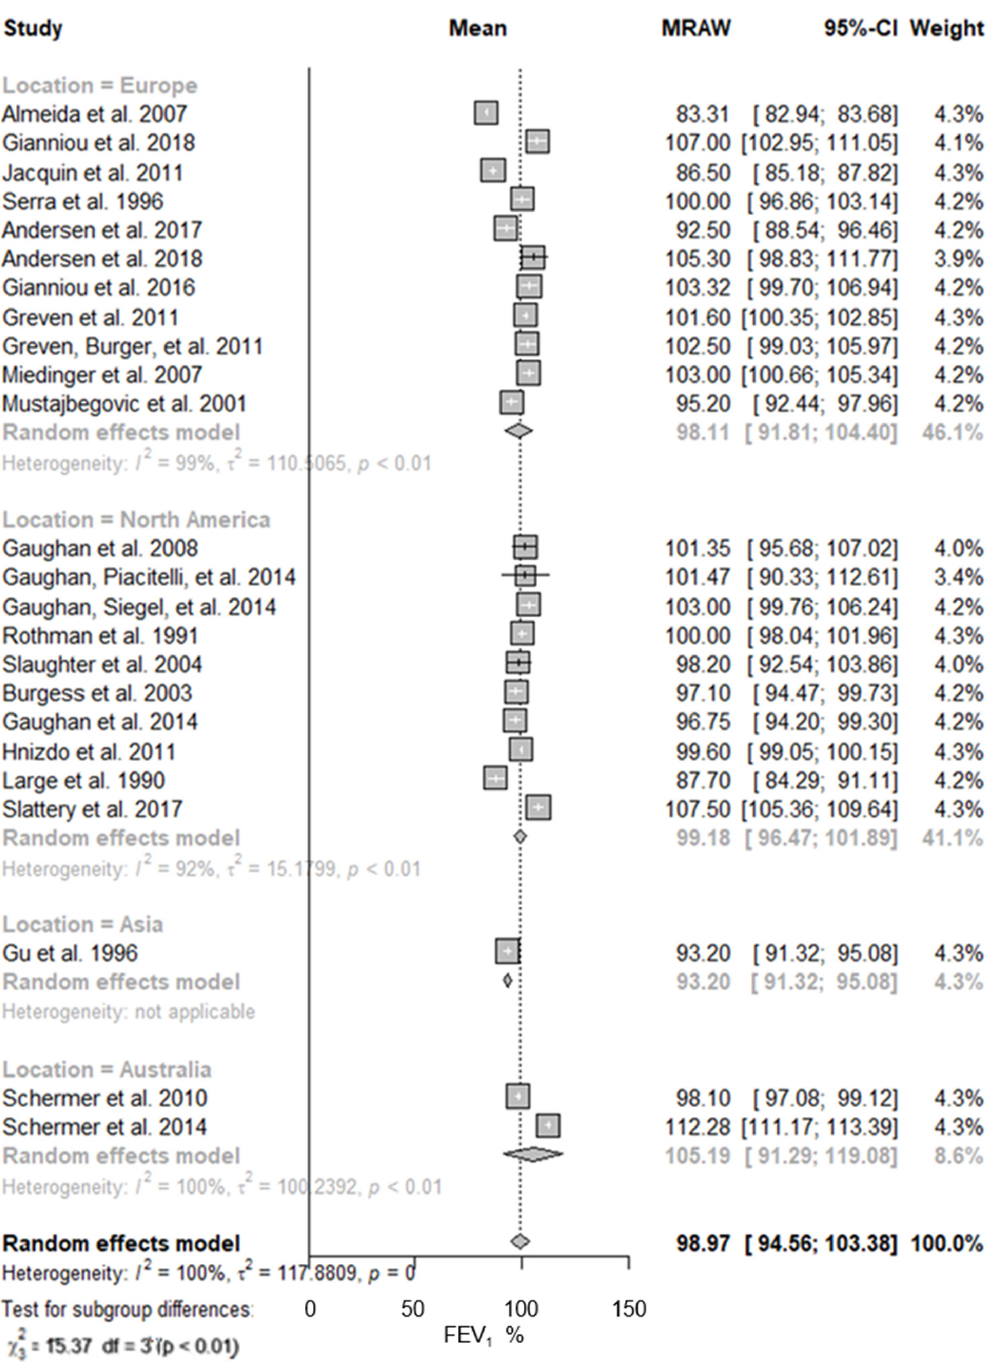
Figure 3. Predicted FEV 1 in firefighters stratified by study location. Forest plot displaying the weight of the predicted FEV 1 mean value and heterogeneity [13,40–62].